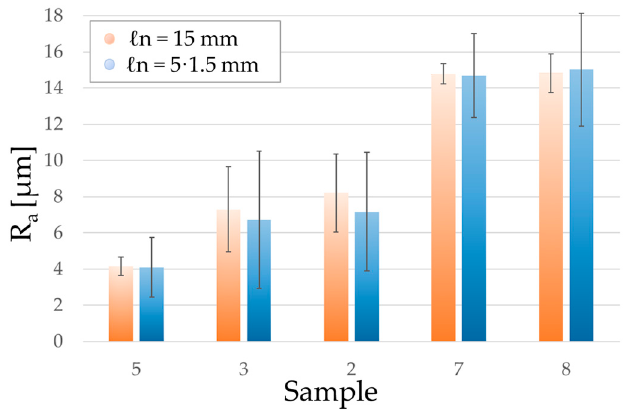
Figure 14. Comparison of results obtained by measuring surface roughness on different evaluation lengths ( (cid:96) n ). The orange bars are the ranges associated with measurements taken on (cid:96) n = 15 mm, lengths ( ℓ n ). The orange bars are the ranges associated with measurements taken on ℓ n = 15 mm, while the blue bars are associated with five distinct measurements taken on (cid:96) n = 1.5 while the blue bars are associated with five distinct measurements taken on ℓ n = 1.5 mm.